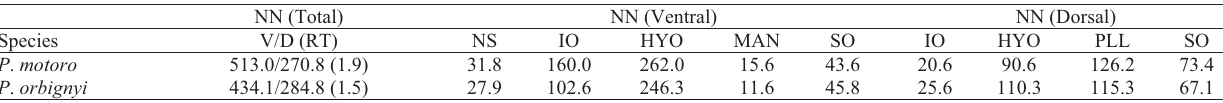
Table 2. Mean number of neuromasts (NN) on the ventral (V) and dorsal (D) surfaces, and their ratio (RT); and for each canal in Potamotrygon motoro and P . orbignyi . HYO) hyomandibular canal; IO) infraorbital canal; SO) supraorbital canal; MAN) mandibular canal; NS) nasal canal; PLL) posterior lateral line canal.